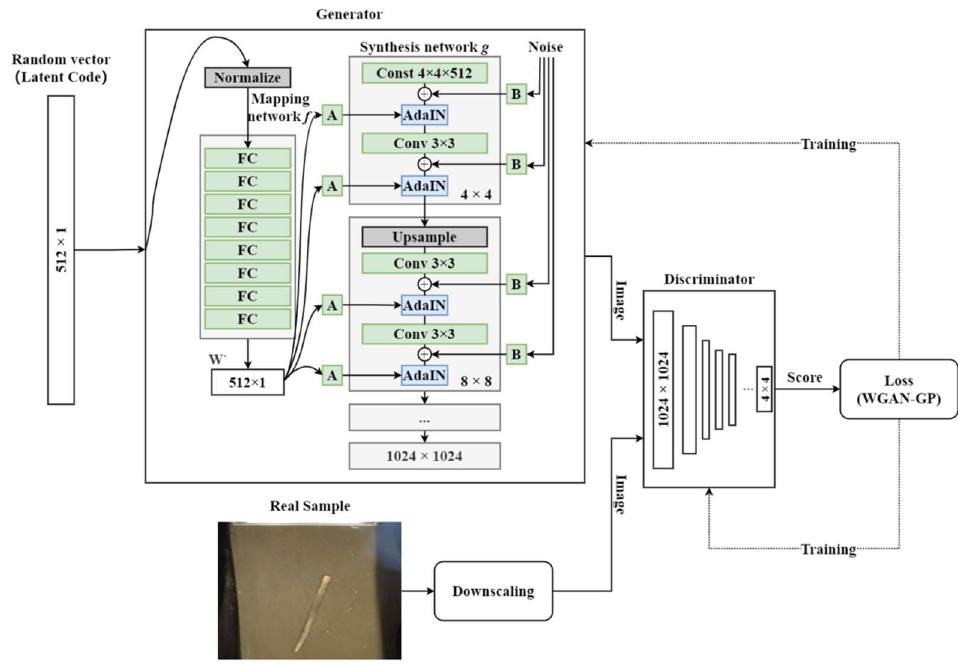
Figure 2. The network structure of